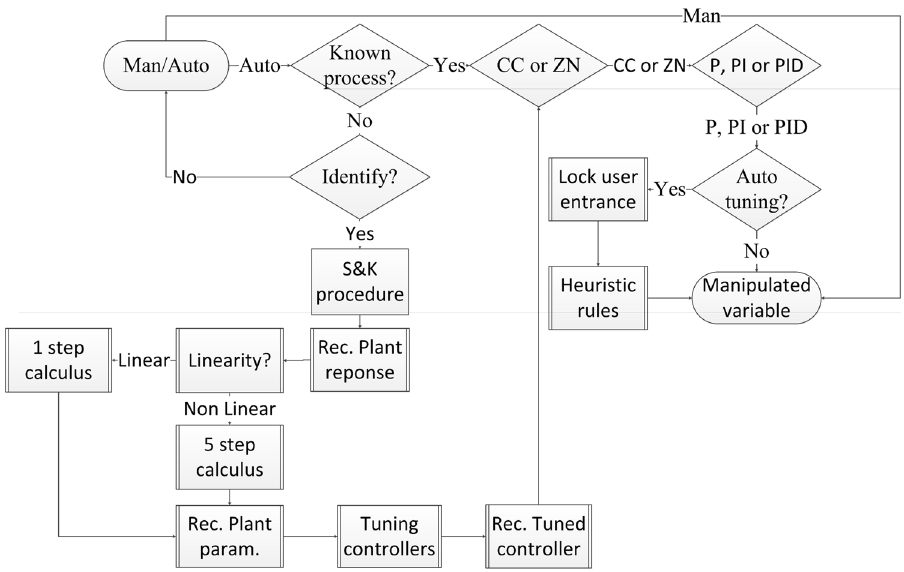
Fig. 2 Simplified schematic of the software design